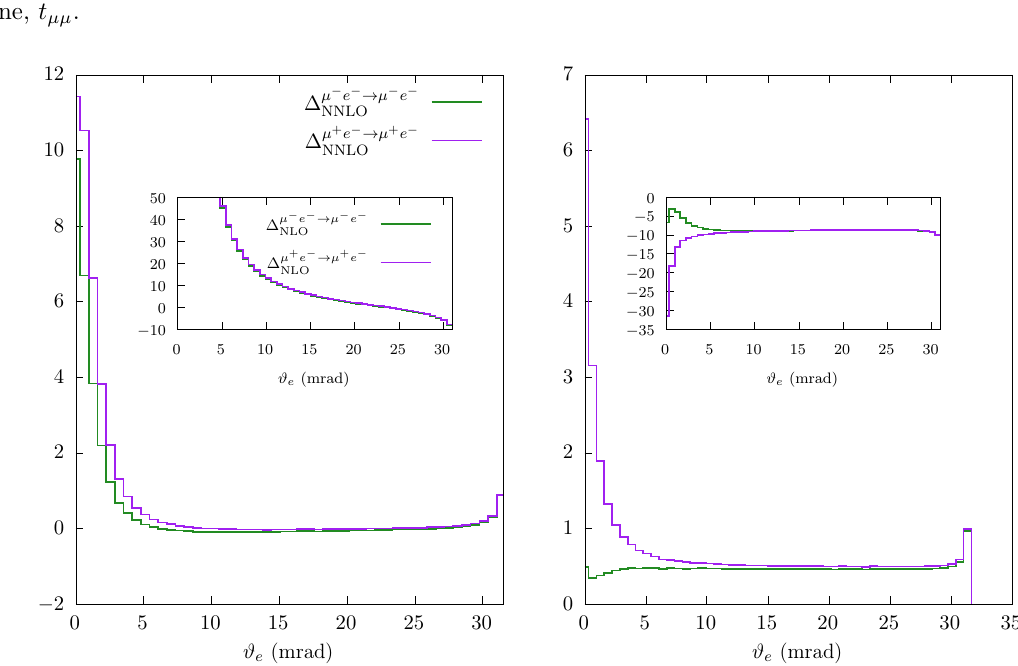
Figure 9 . Approximation to the full NNLO corrections, according to eq. (3.5) or (3.6), as a function of # e . The green histogram refers to the process (cid:22) (cid:0) e (cid:0) (cid:22) (cid:0) e (cid:0) while the violet histogram ! refers to (cid:22) + e (cid:0) (cid:22) + e (cid:0) . Left panel: di(cid:11)erential distribution in the presence of acceptance cuts ! only (Setup 1); right panel: the same as in the left panel with the additional acoplanarity cut of Setup 2. The insets report the NLO corrections, according to eq. (4.3).